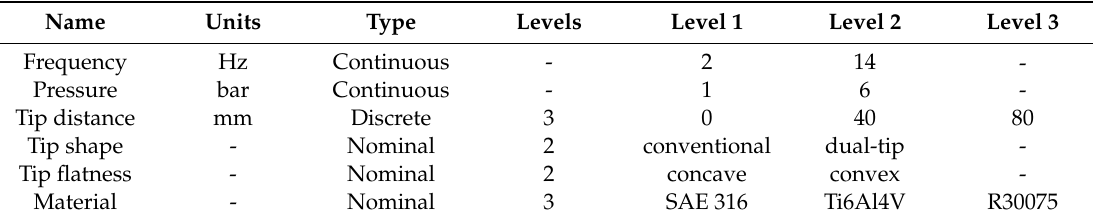
Table 2. Response surface method optimal design